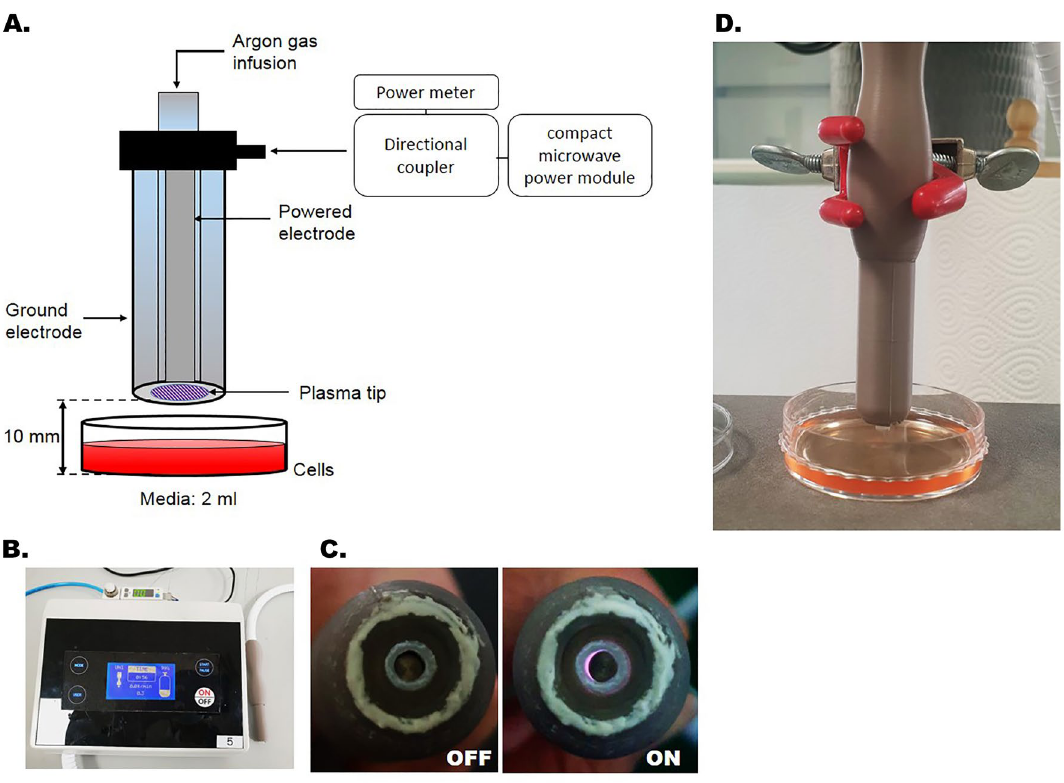
Figure 1. The NTP-generating device. ( A ) Principle sketch of NTP device and its generation. ( B ) NTP generated from the device. ( C ) Plasma glow within the electrodes. ( D ) NTP treatment of cells. The electrodes were maintained at a distance of 1 cm from the